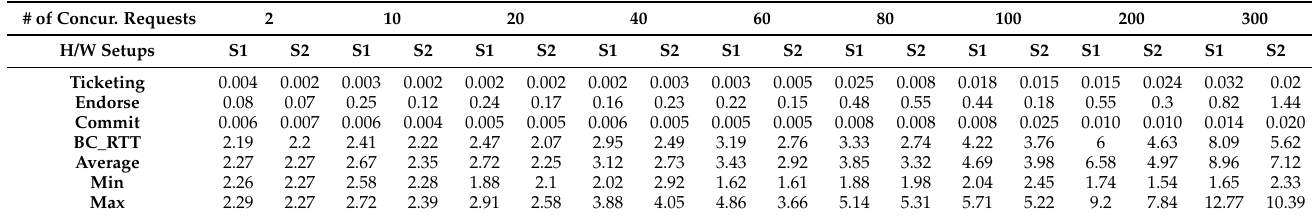
Table 5. Detailed performance evaluation for various scenarios of concurrent requests and h/w setups (time in s).